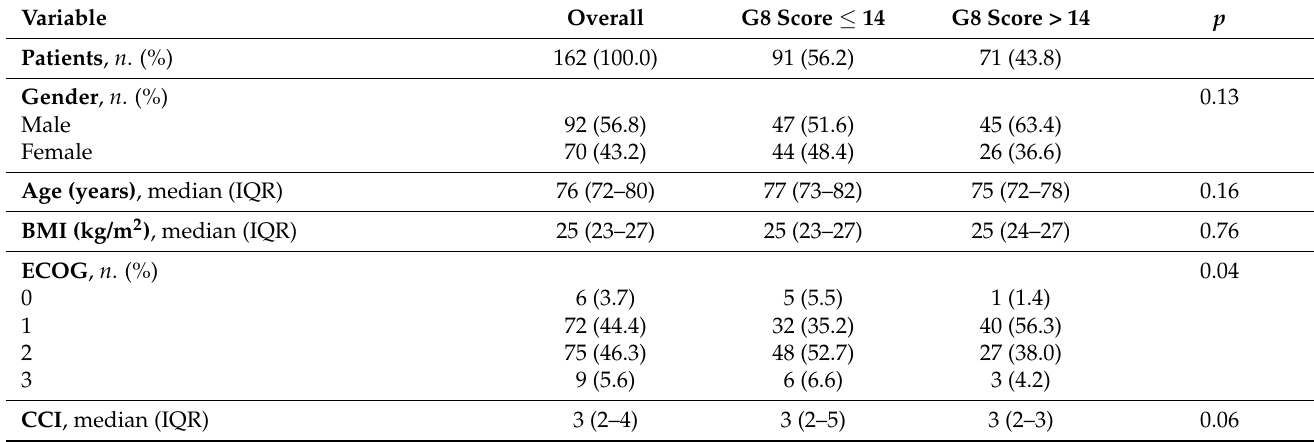
Table 1. Descriptive baseline, surgical characteristics, and clinicopathological features for the cohort of 162 patients with renal mass treated with radical or partial nephrectomy according to G8 Screening Tool